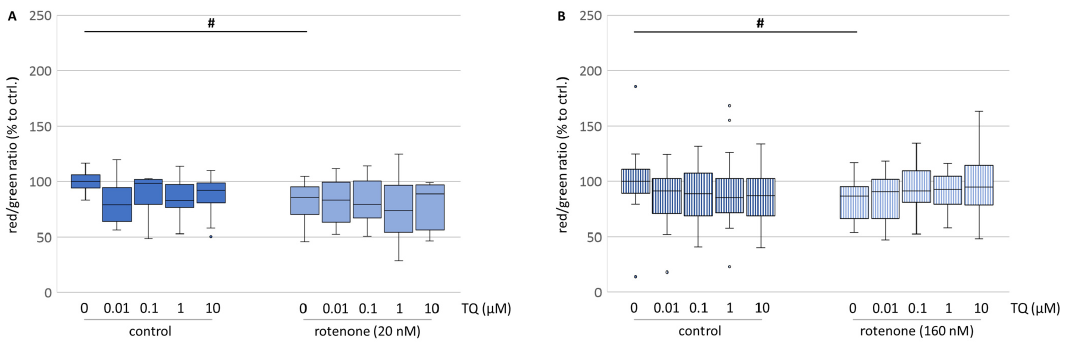
Figure 7. Effects of TQ on the mitochondrial membrane potential of the primary mesencephalic cultures ( A ) and the neuroblastoma cell line ( B ) in the absence and presence of rotenone after 48 h treatment. The untreated control groups (0 µM TQ, 0 nM rotenone) were set to 100%. The data represent five ( A ) or eight ( B ) independent experiments. Statistical significance was determined using the Mann–Whitney (U) test (# p < 0.05).